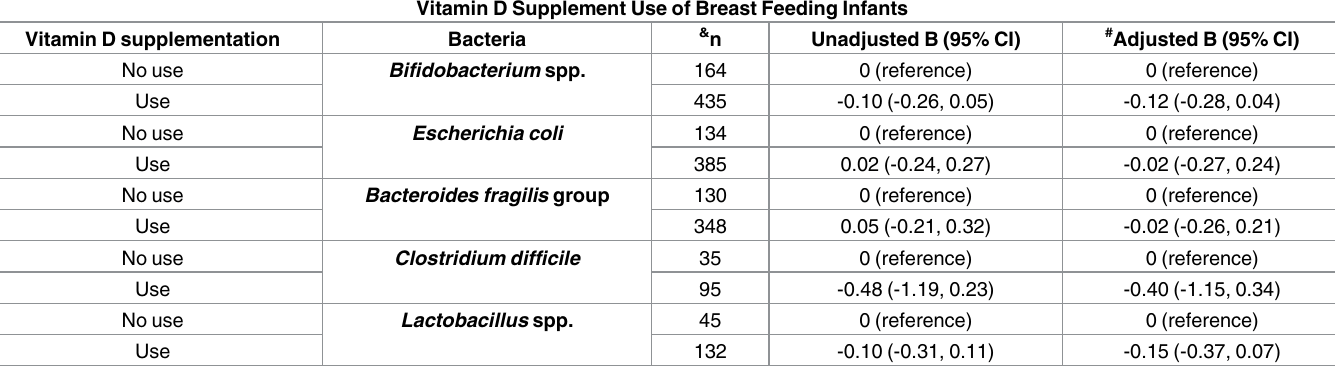
Table 5. Association between vitamin D supplementation of the infant and log 10 colony forming units/g feces of bacterial species or groups in breast fed infants (n = 616) colonized with the respective bacteria. Vitamin D Supplement Use of Breast Feeding